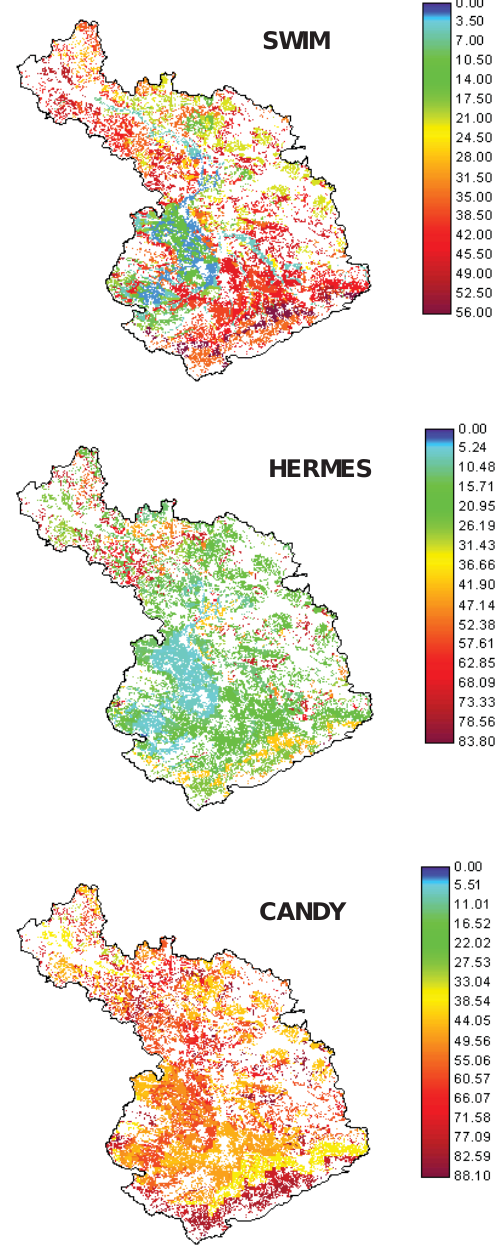
Fig. 5. Spatial distribution of simulated long term average N-leaching in kg/(ha ∗ a) (1961–1990) for increased fertilization (125%) on arable land in the Elbe river